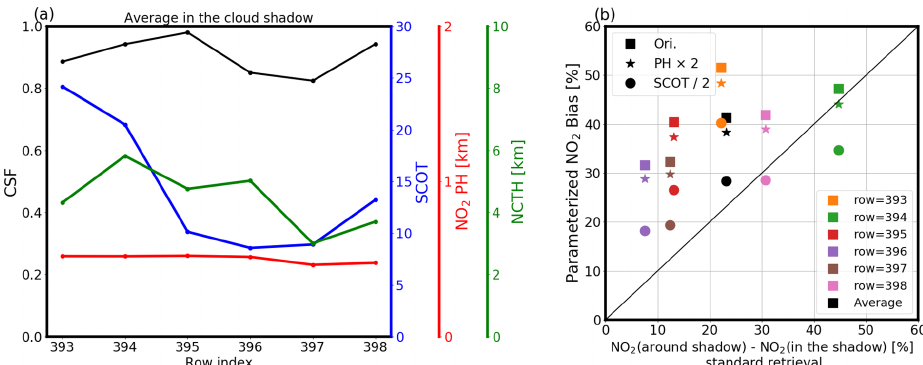
Figure 20. Estimation of NO 2 retrieval biases over the cloud shadow bands from TROPOMI measurements on 30 December 2019. (a) Aver- aged parameters in the cloud shadow, which are used to estimate the bias. (b) Comparison of the estimated bias and the NO 2 bias calculated based on the difference of NO 2 retrieval around and in the cloud shadow. The black is the average over all the rows, and the stars and the circles correspond to the estimation using doubled NO 2 profile height and halved slant cloud optical thickness. See the text for further